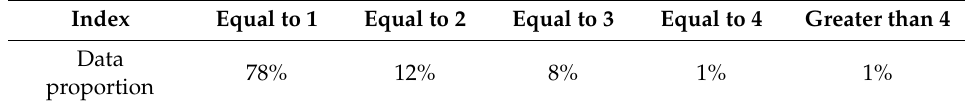
Table 2. Statistics for the number of abnormal values plus the number of missing values.